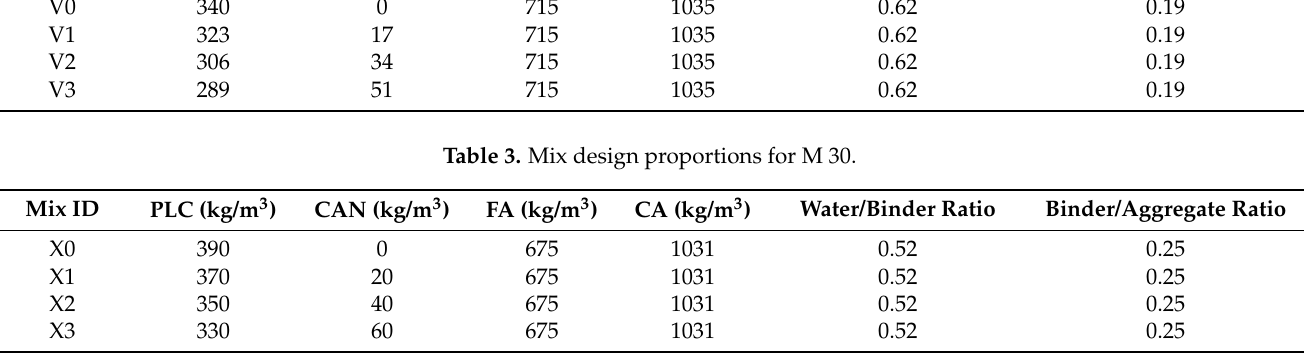
Table 2. Mix design proportions for M 25.